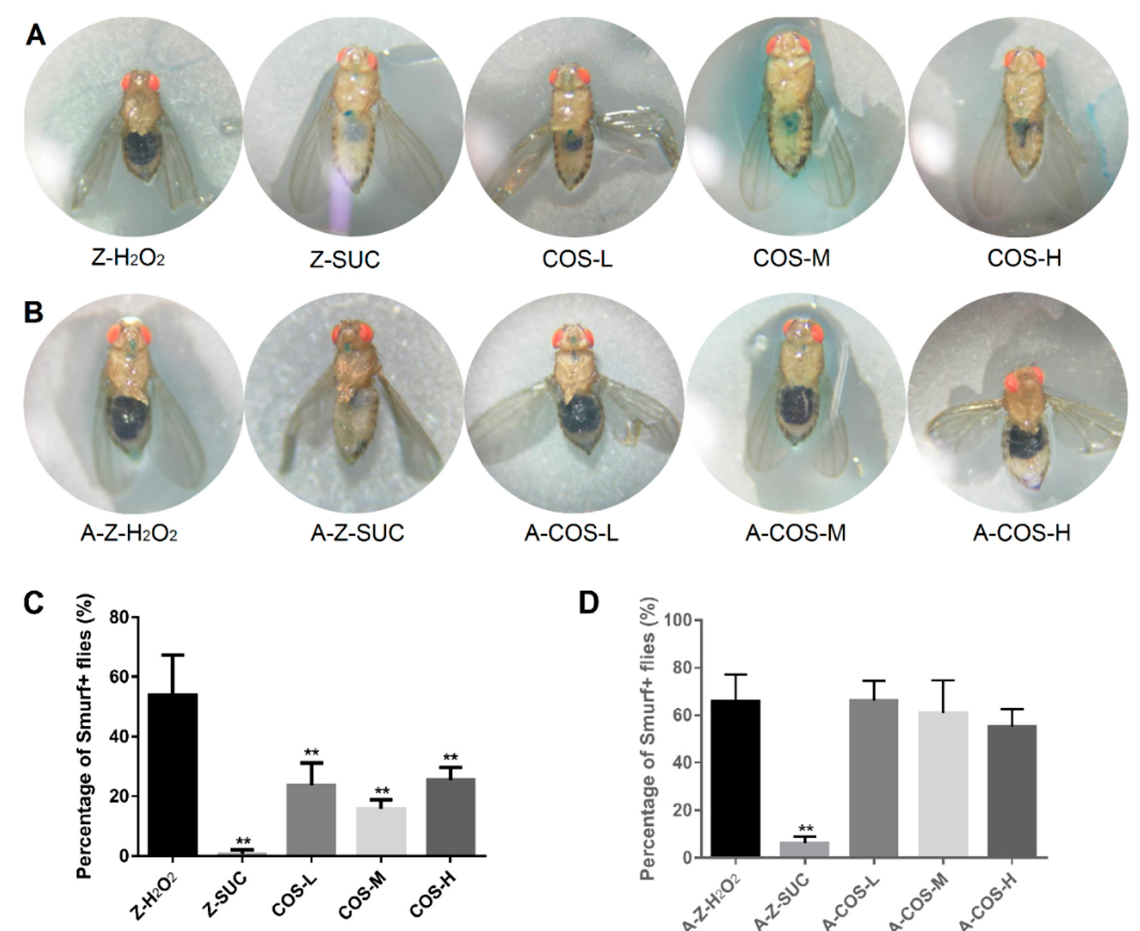
Figure 4. The effect of COS on gut integrity in female Drosophila . The dye of FD & C Blue No.1 is displayed in female Drosophila ( A ) and axenic female Drosophila ( B ) with different treatments. The percentage of “Smurf” flies in normal and axenic types are shown in ( C ) and ( D ) respectively. Differences among treatments were obtained with one-way analysis of variance followed by Tukey’s multiple comparisons test. When compared with the H 2 O 2 treated group, ** represent p < 0.01 respectively.